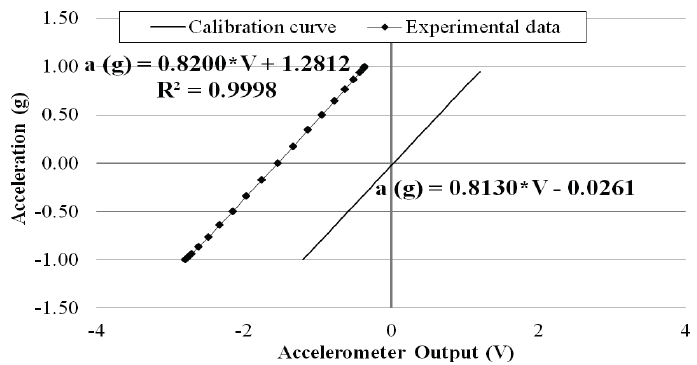
Figure 7. Results of accelerometer system calibration